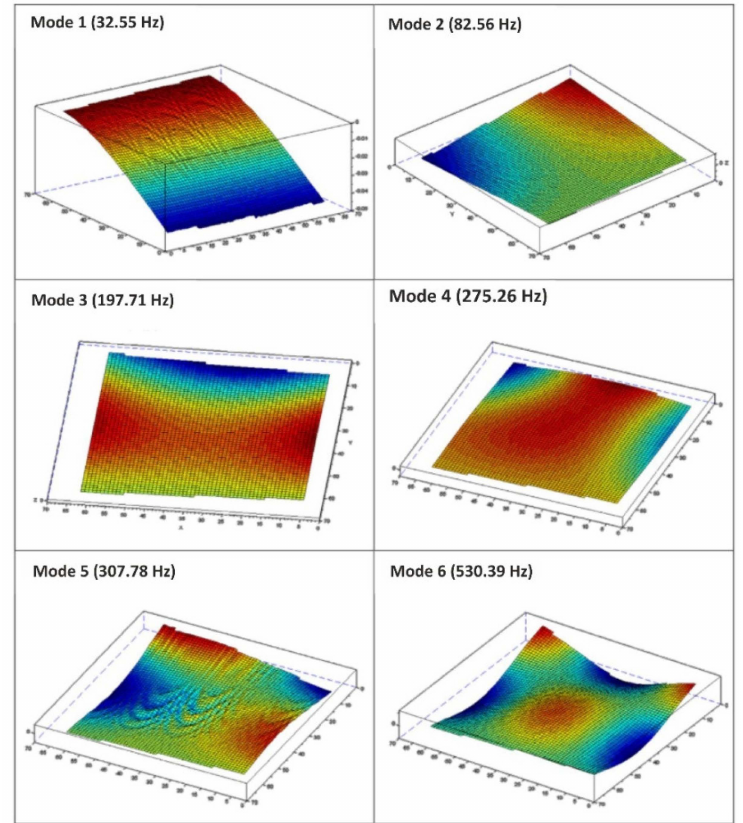
Figure 14. Modal shapes and corresponding EMA